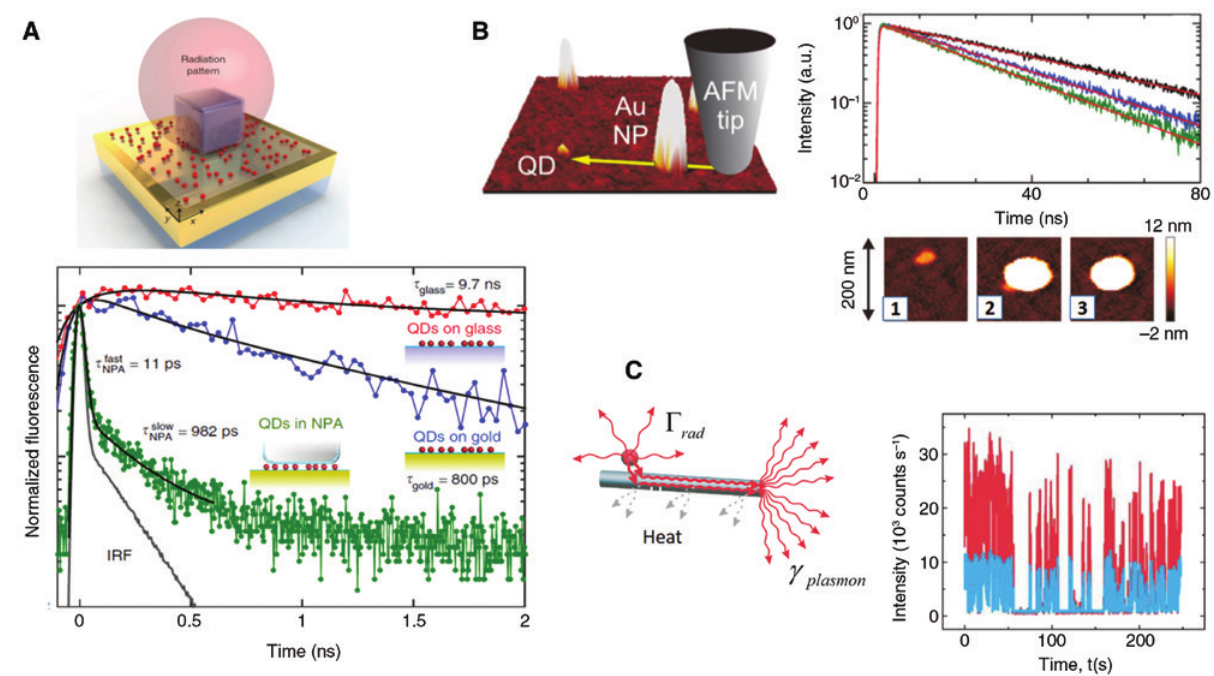
Figure 3: Probing and employing weak coupling. (A) Top: 3D illustration of a single silver nanocube separated from a gold film by a thin polymer spacer layer containing QDs.